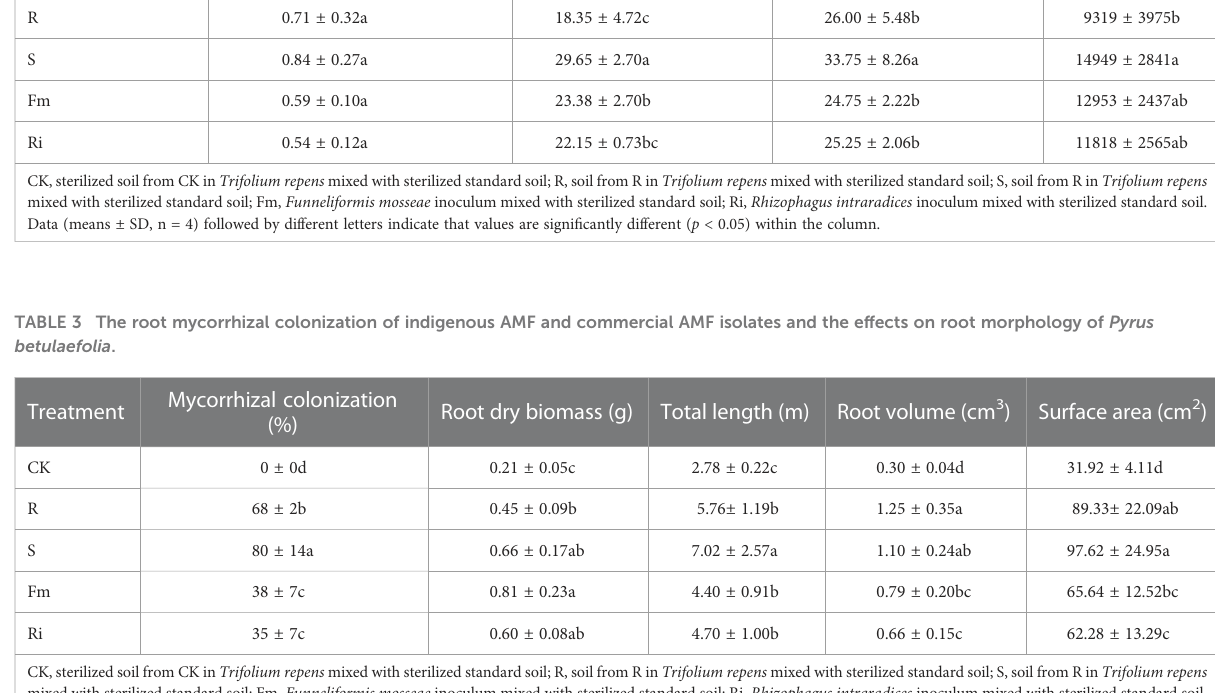
CK,sterilizedsoilfromCKin Trifoliumrepens mixedwithsterilizedstandardsoil;R,soilfromRin Trifoliumrepens mixedwithsterilizedstandardsoil;S,soilfromRin Trifoliumrepens mixed with sterilized standard soil; Fm, Funneliformis mosseae inoculum mixed with sterilized standard soil; Ri, Rhizophagus intraradices inoculum mixed with sterilized standard soil. Data (means ± SD, n = 4) followed by different letters indicate that values are signi fi cantly different ( p < 0.05) within the